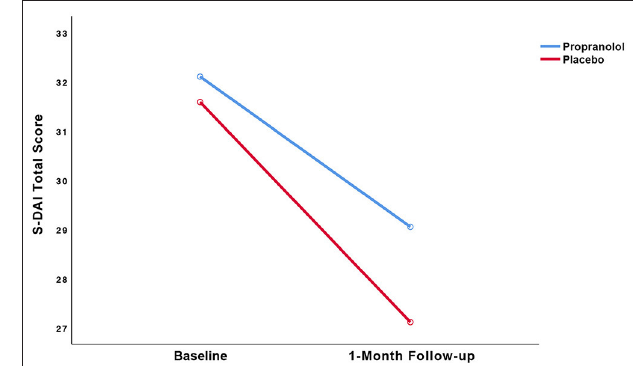
FIGURE 3 | Observed trajectories of the dental anxiety (S-DAI) scores as a function of treatment group.